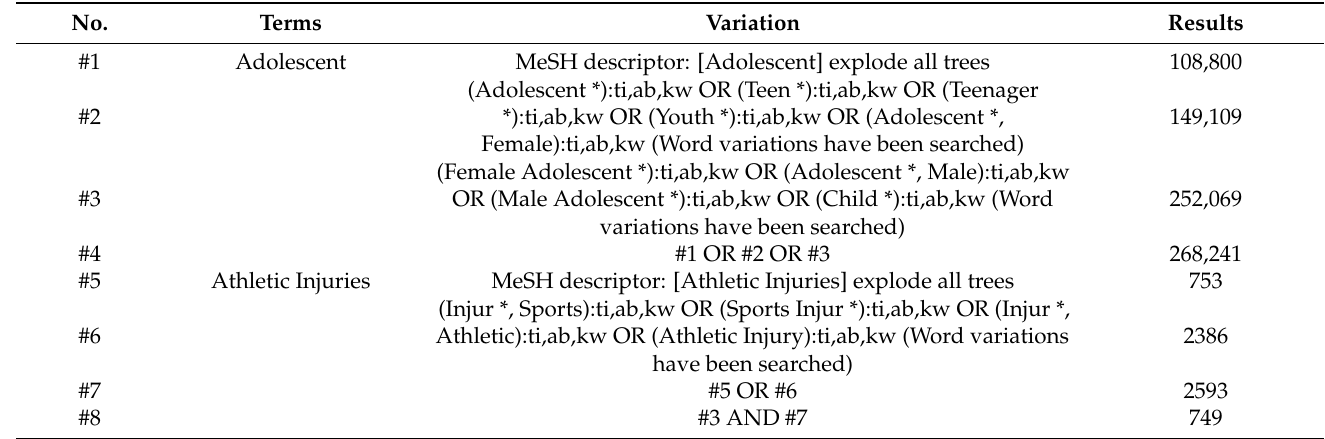
Table A5. Cochrane Search Terms and Variations Used for Systematic Search.